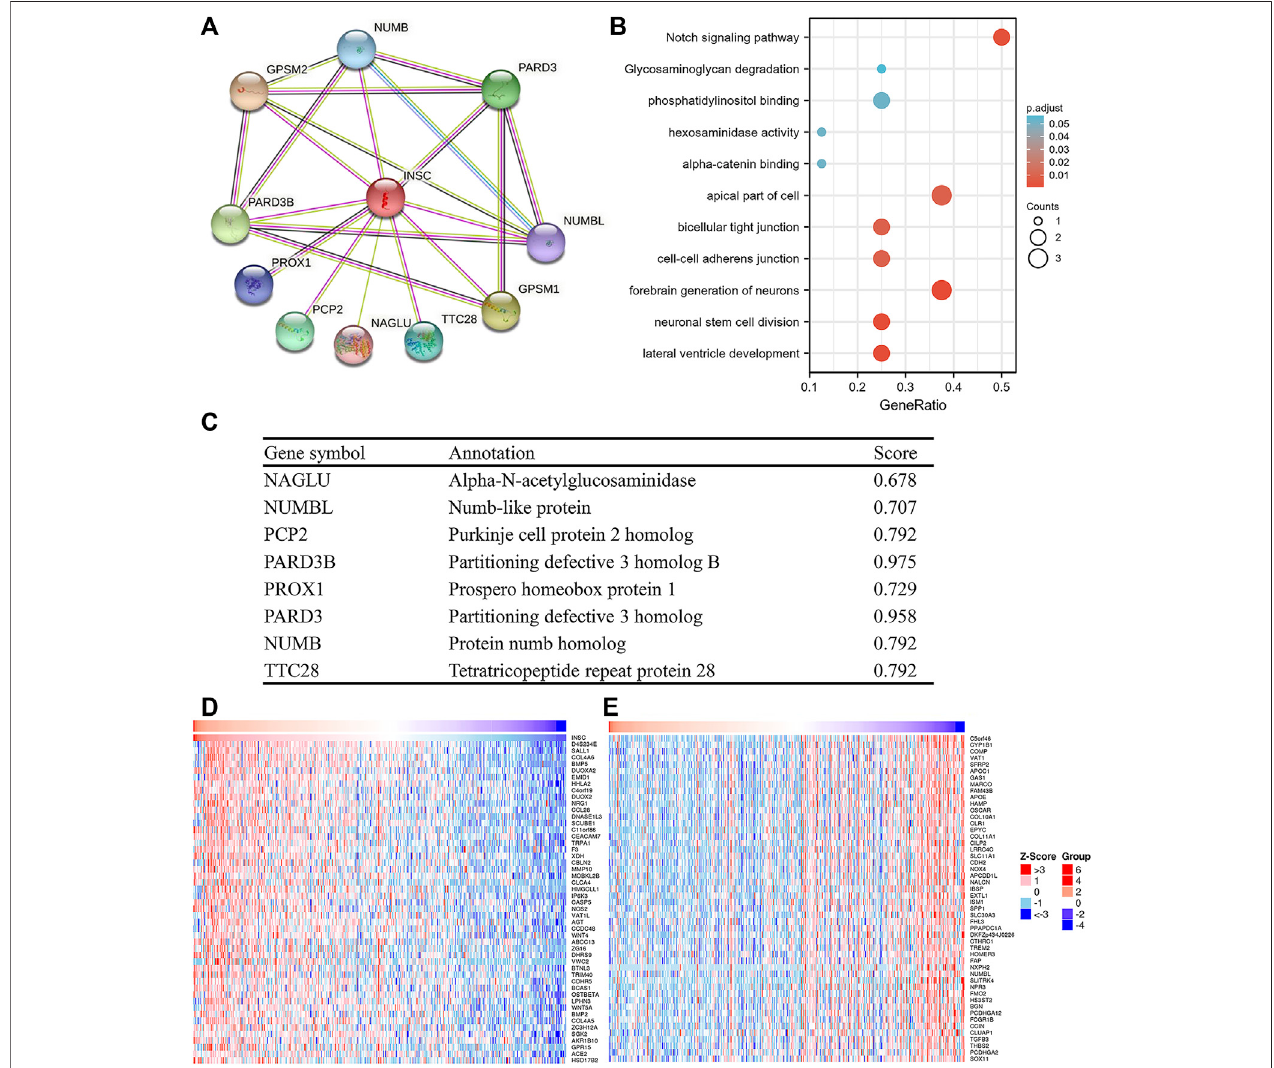
FIGURE 5 | PPIand GO/KEGG analysis of INSC. (A) PPI network ofINSC. (B) Bubble chart showing the enrichment results. (C) The detailed information of INSC- related genes. (D) Top 50 positively or negatively signi fi cant correlated genes with INSC.